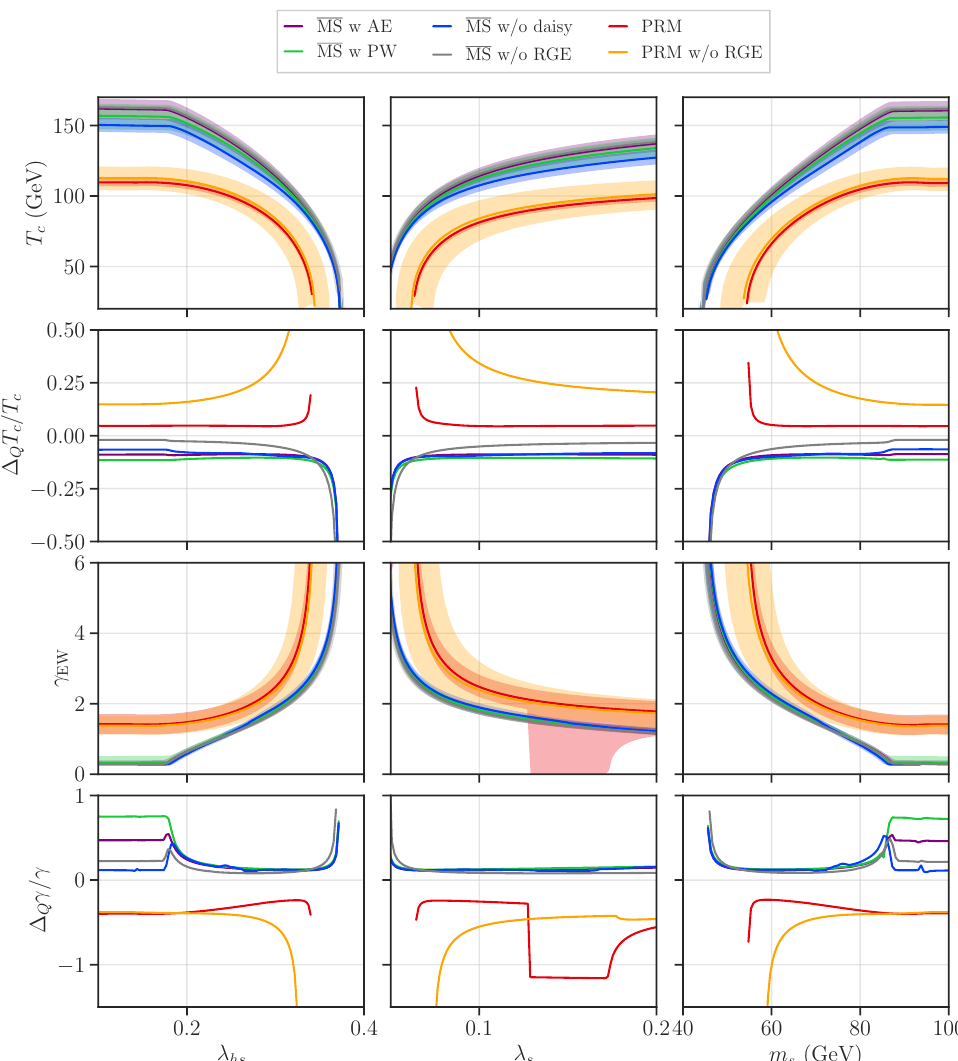
Figure 5 . The renormalisation scale dependence in the MS scheme and PRM method found by varying the renormalisation scale from Q = 1 parameter of the benchmark point in eq. (4.1). The lower edges, center and upper edges of the bands in the first and third rows show the T second and last rows show the fractional change in T PW’ and ‘w/o daisy’ indicate daisy resummation with the Arnold-Espinosa method, the Parwani method, and no resummation,